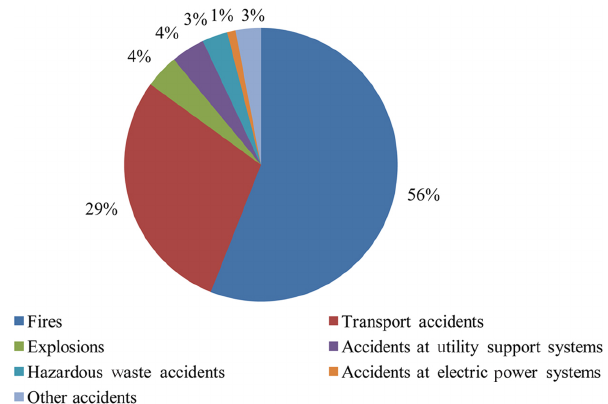
Figure 10. Distribution of frequently repeated technological emer- gencies.